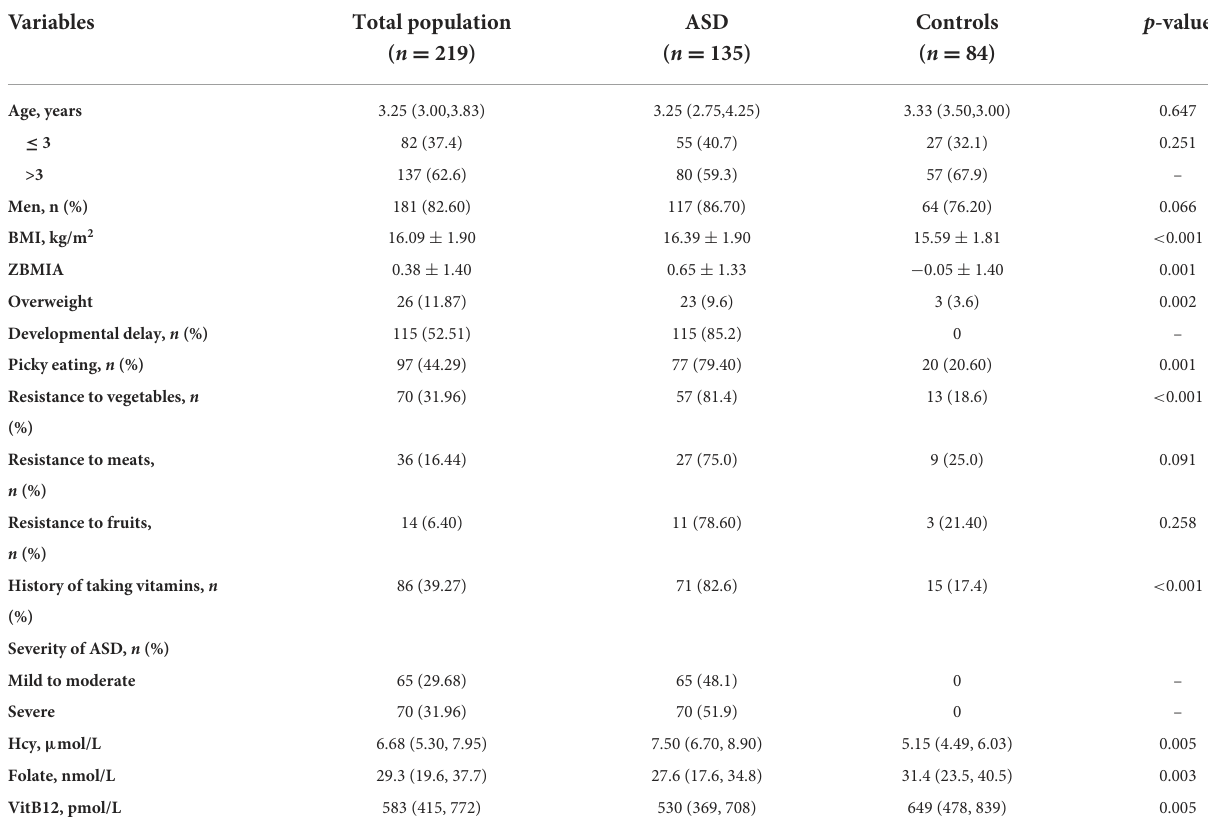
TABLE 1 General characteristics of the participants in the study.